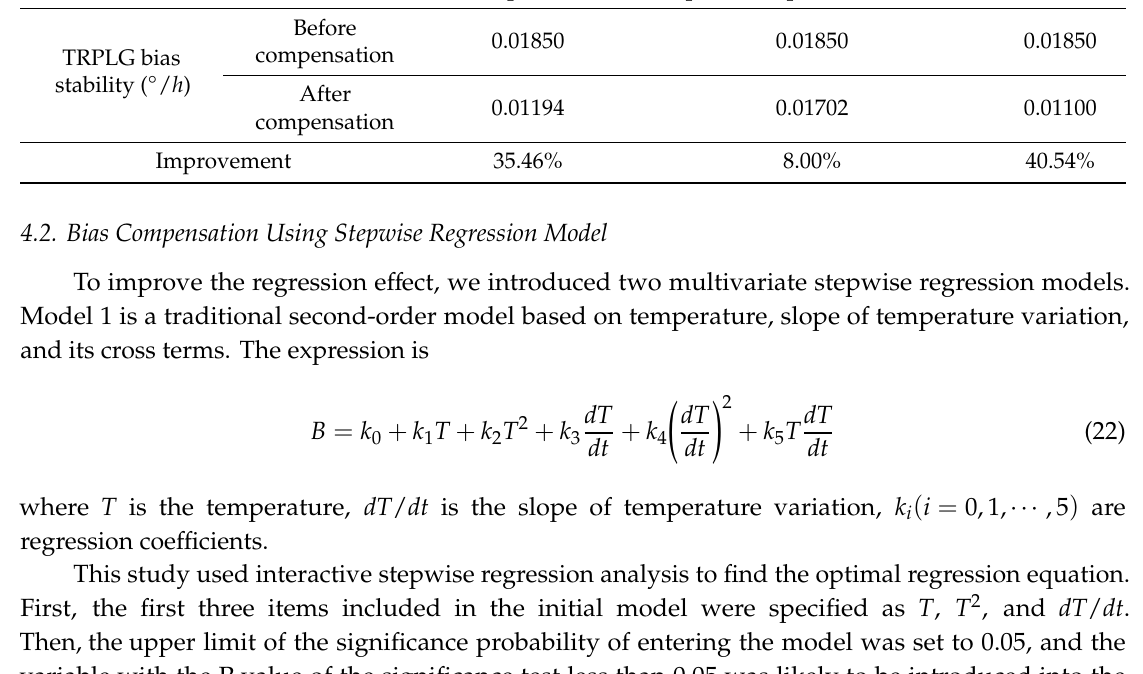
Figure 7. TRPLG bias compensation using different parameters based on LS model: ( a ) Results of